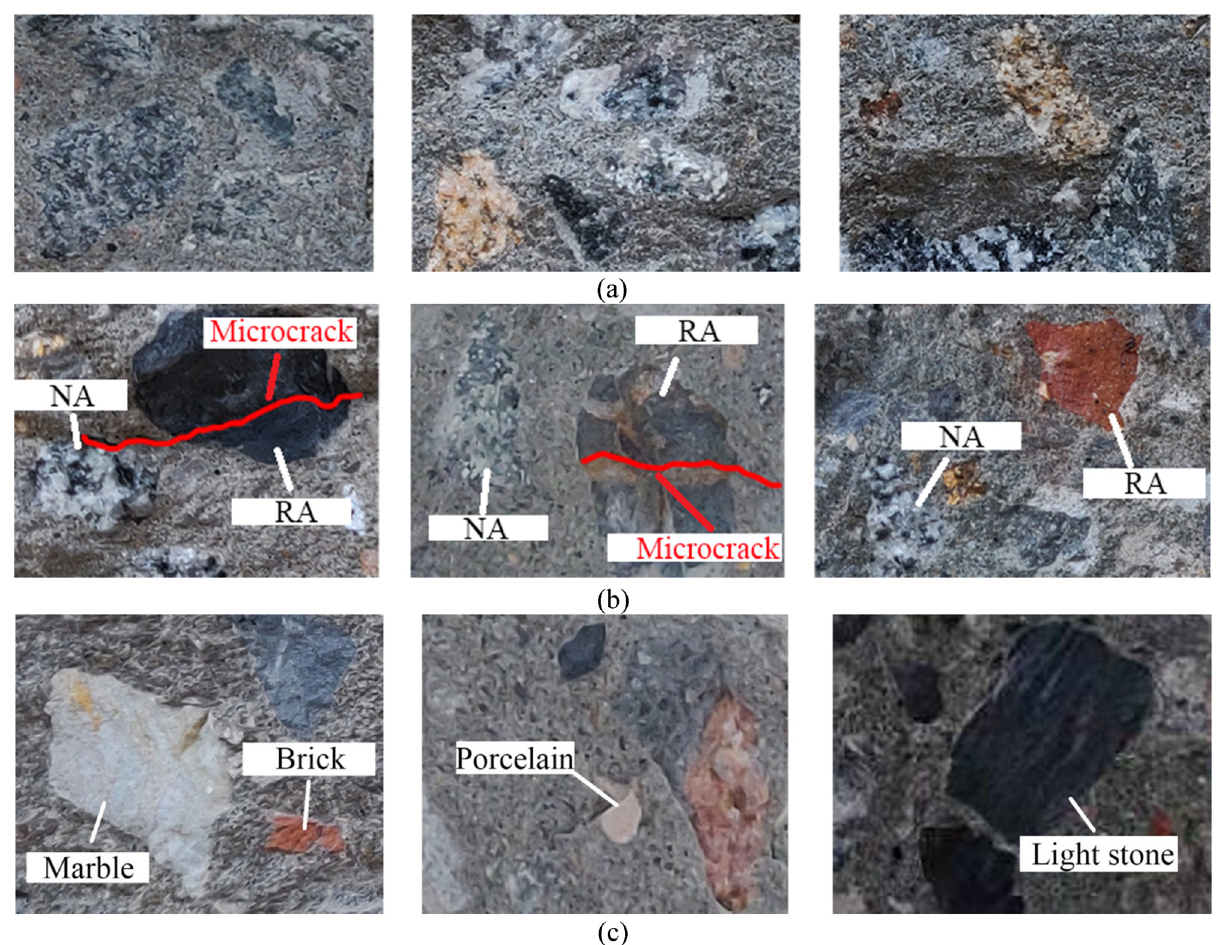
Figure 10: Failure modes of tensile test specimens: ( a ) 0%, ( b ) 50%, and ( c ) 100% RA replacement.